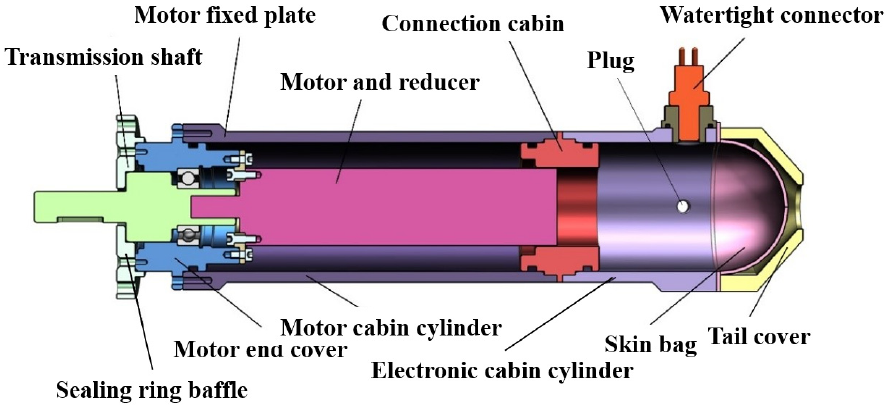
Figure 4. Structure diagram of underwater oil filling motor.